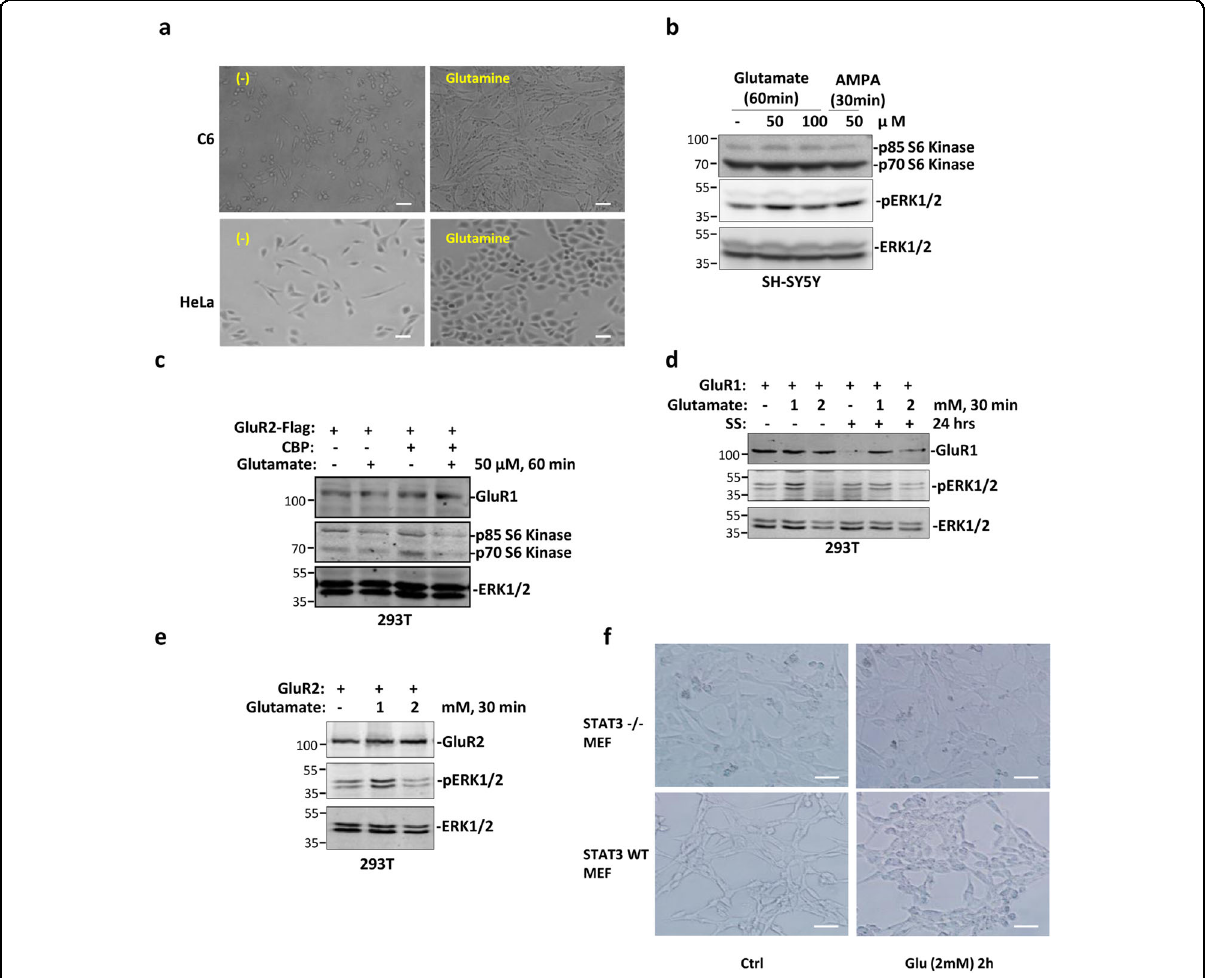
Fig. 6 Glutamate-induced cell proliferation is mediated by STAT3. a C6 and Hela cells were treated with glutamine and cell proliferation was observed by microscopy. Scale bar: 50 μ m. Data shown are representative of three independent experiments. b SH-SY5Y cells were with either glutamate or AMPK, cells were lysed and blotted with indicated antibodies. Data shown are representative of two independent experiments. c 293 T cells were transfected with indicated plasmids and then were treated with or without glutamate. Cells were lysed and blotted with indicated antibodies. d 293 T cells were transfected with GluR1 followed by treatment with glutamate or serum starvation. Cells were lysed and blotted with indicated antibodies. e 293 T cells were transfected with GluR2 followed by treatment with glutamate for different time. Cells were lysed and blotted with indicated antibodies. f Wild-type and STAT3 − / − MEF cells were treated with glutamate. Cell proliferation was observed by microscopy. Scale bar: 50 μ m. Data shown are representative of two independent